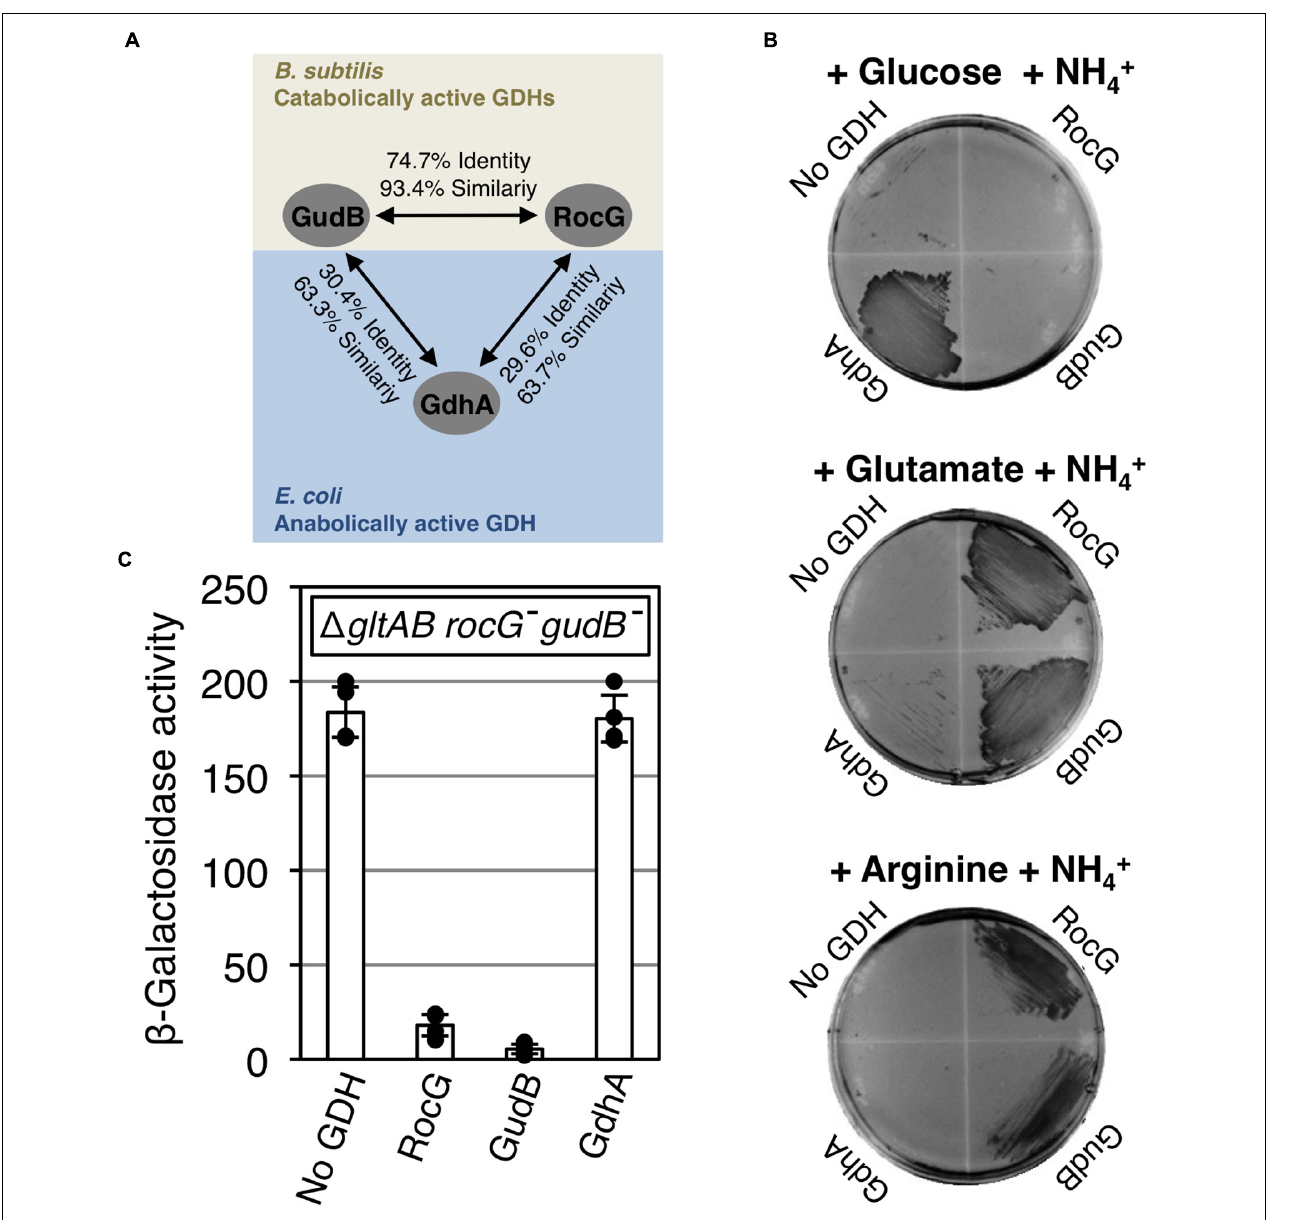
FIGURE 8 | Inactivation of the P gltA promoter by GltC depends on the native GDHs RocG and GudB1. (A) Overall amino acid sequence identity and similarity between B. subtilis RocG and GudB1 and E. coli GdhA. (B) Growth experiments with the strains BP220 ( (cid:49) gltAB P gltA -lacZ rocG − gudB − ) + pBQ200 (empty plasmid), BP220 + pGP529 ( rocG ), BP220 + pGP482 ( gudB1 ) and BP220 + pGP934 ( gdhA ) on C minimal medium plates containing ammonium as a source of nitrogen and either 0.5% (w/v) glucose, 0.8% (w/v) glutamate or 0.5% (w/v) arginine as sources of carbon. (C) Arginine-dependent regulation of the P gltA promoter in the strains BP220 + pBQ200, BP220 + pGP529, BP220 + pGP482, and BP220 + pGP934 in CSE-Glc medium. Arginine was added to a final concentration of 0.5% (w/v). Data points represent biologically independent replicates. Bars indicate means of replicates and the standard deviations are shown. β -Galactosidase activities are given as units per milligram of